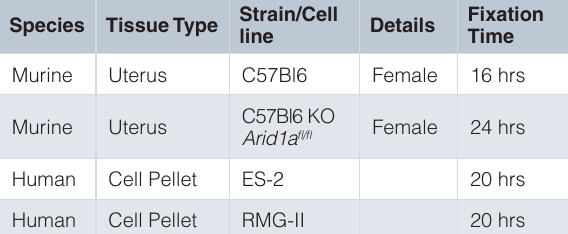
Strain/Cell line